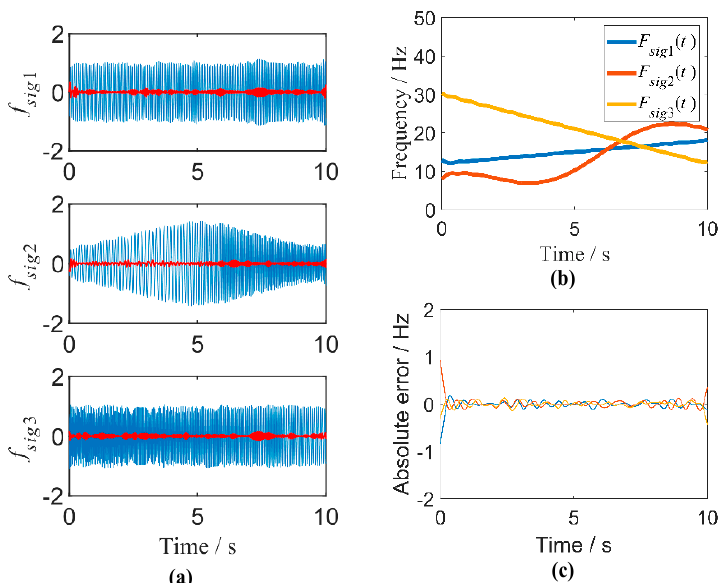
Figure 5. Analysis results with SNR = 18 dB. ( a ) The estimated modes by VSME. ( b ) Frequency of